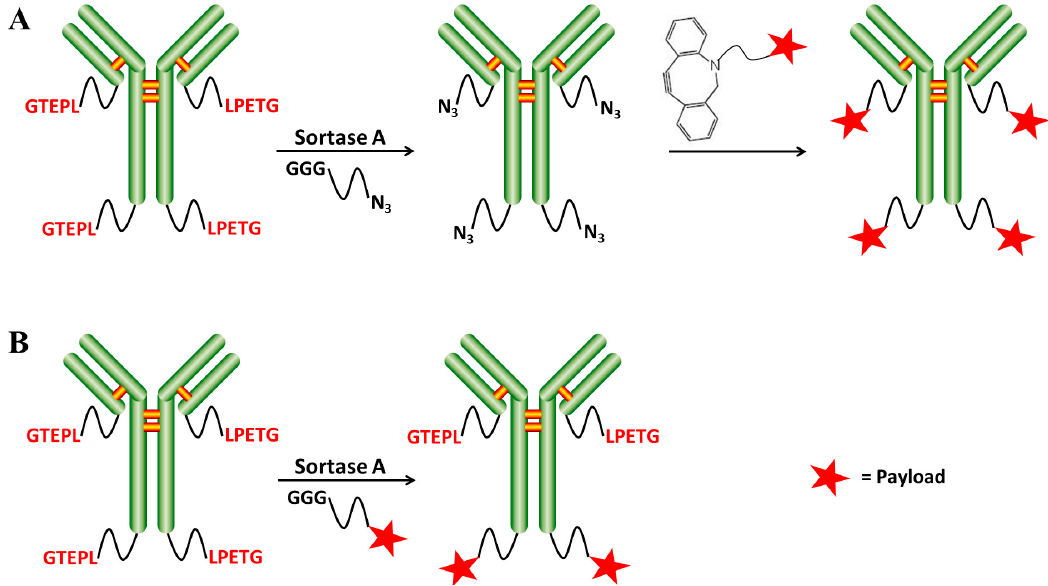
Figure 3. Schematic illustration of the two different strategies to generate homogeneous antibody-drug conjugates (ADCs). ( A ) For the chemo-enzymatic approach, a bifunctional oligoglycine-modified small molecule is enzymatically attached to the LPETG-tagged antibody in a first reaction. In a second step, the toxin, which is modified with a suitable functional group, is conjugated to the antibody via strain-promoted azide-alkyne cycloaddition (SPAAC); ( B ) The direct enzymatic approach includes direct conjugation of an oligoglycine-functionalized toxin to the LPETG-tagged antibody. LPXTG: L, leucine; P, proline; T, threonine; G, glycine; X can be any amino acid.